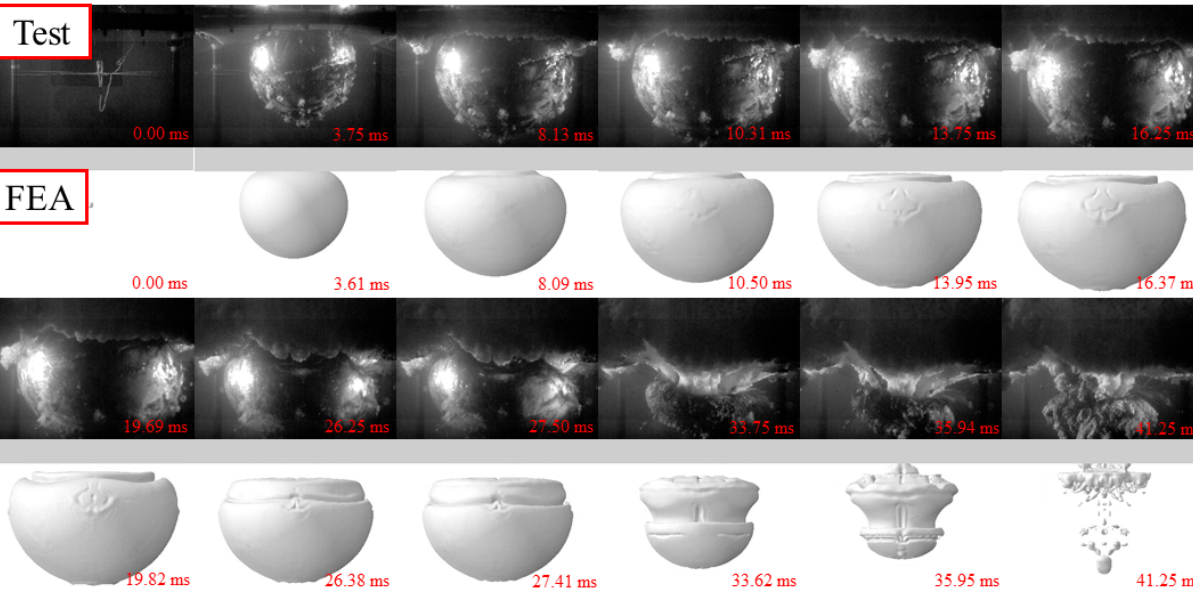
Figure 4. Whole process of underwater explosion for 5 g TNT.